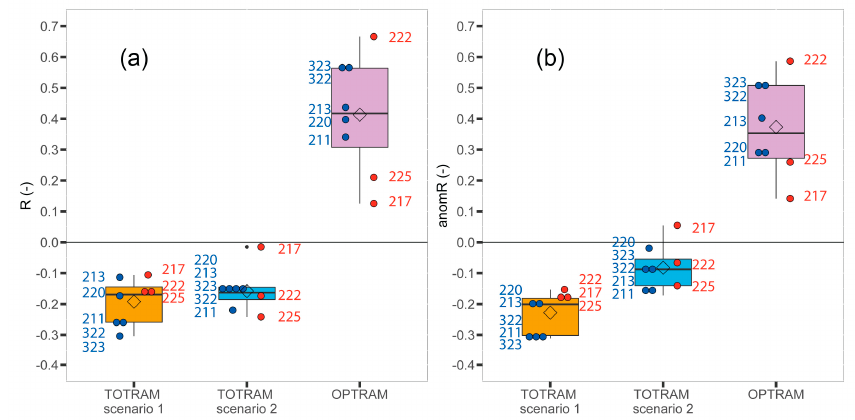
Figure 6. Temporal Pearson correlation coefficient for ( a ) original (R) and ( b ) anomaly time series (anomR) for TOTRAM Scenario 1, TOTRAM Scenario 2, and OPTRAM. Dots present the value of R and anomR of individual wells (numbers as indicated in Figure 3) in treed (red) and treeless (blue) parts of the bog. Boxplots present the distribution of all wells with the bold line indicating the median value and the diamond representing the mean value.